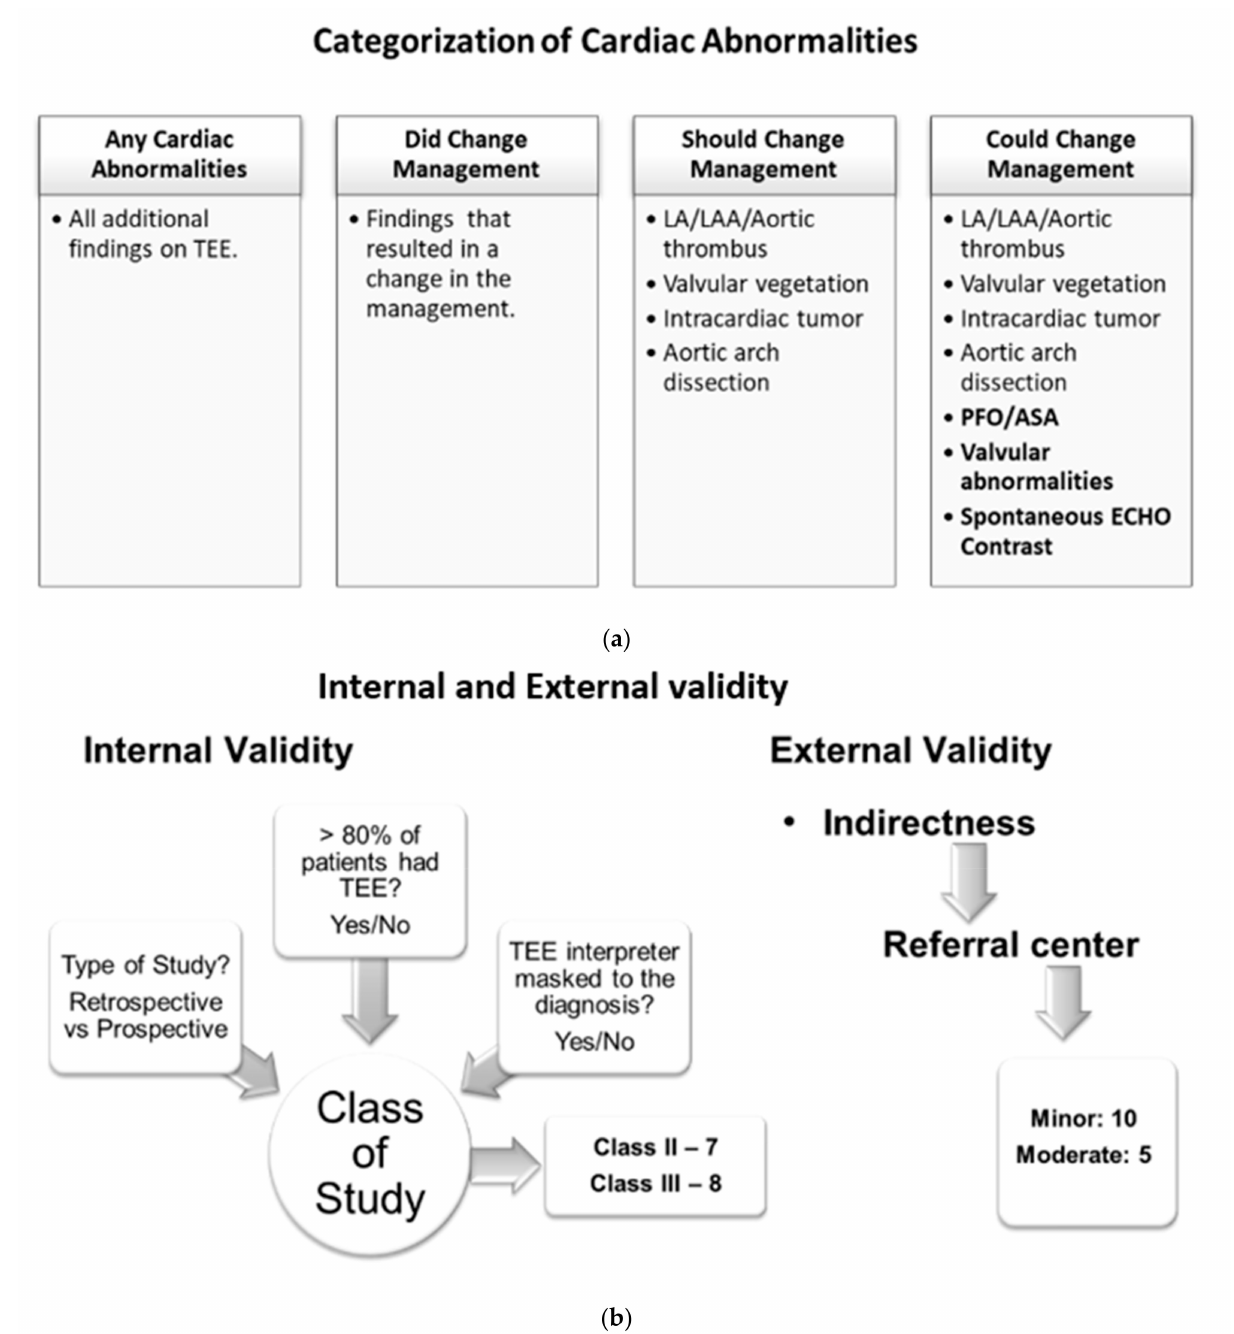
Figure 2. ( a ) Categories of cardiac abnormalities on TEE findings. ( b ) Internal and external validity evaluation of the included